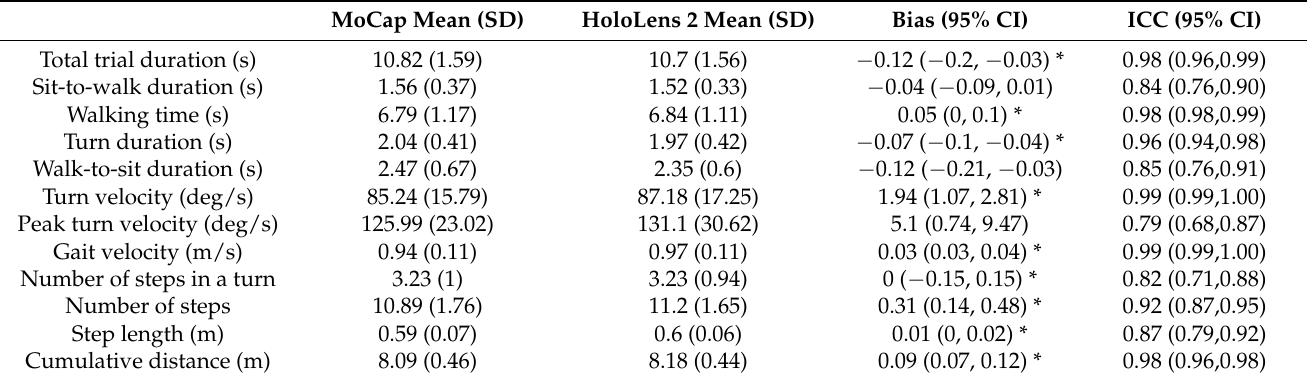
Table 3. Biomechanical outcomes from the MoCap and HL2 systems for timed up-and-go task. MoCap Mean